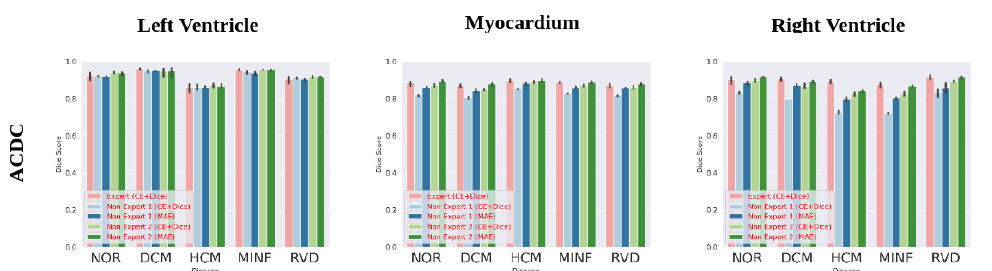
Figure 4. Dice score on ACDC per disease. NOR: Normal, DCM: Dilated cardiomyopathy, HCM: Hy- pertrophic cardiomyopathy, MINF: Myocardial infarction, RVD: Right ventricle